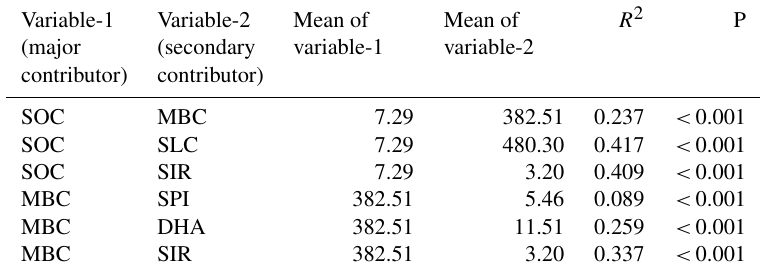
Table 3. Pair of variables used for the quadrant plot and their mean and regression coefficient ( R 2 ).